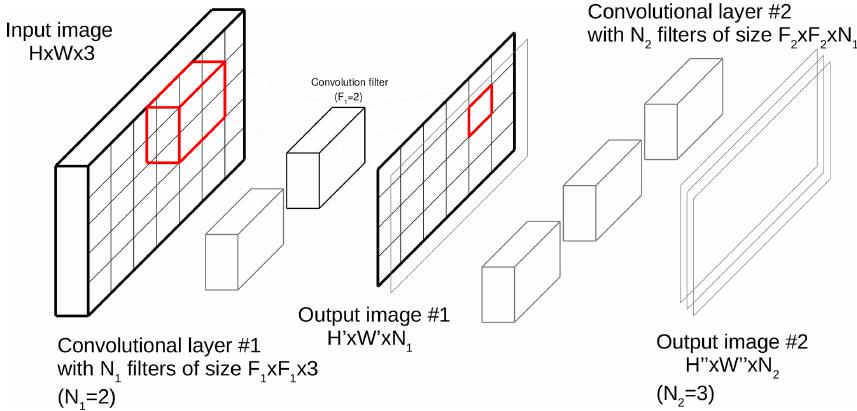
Figure 2. Example of convolution layers inside a neural